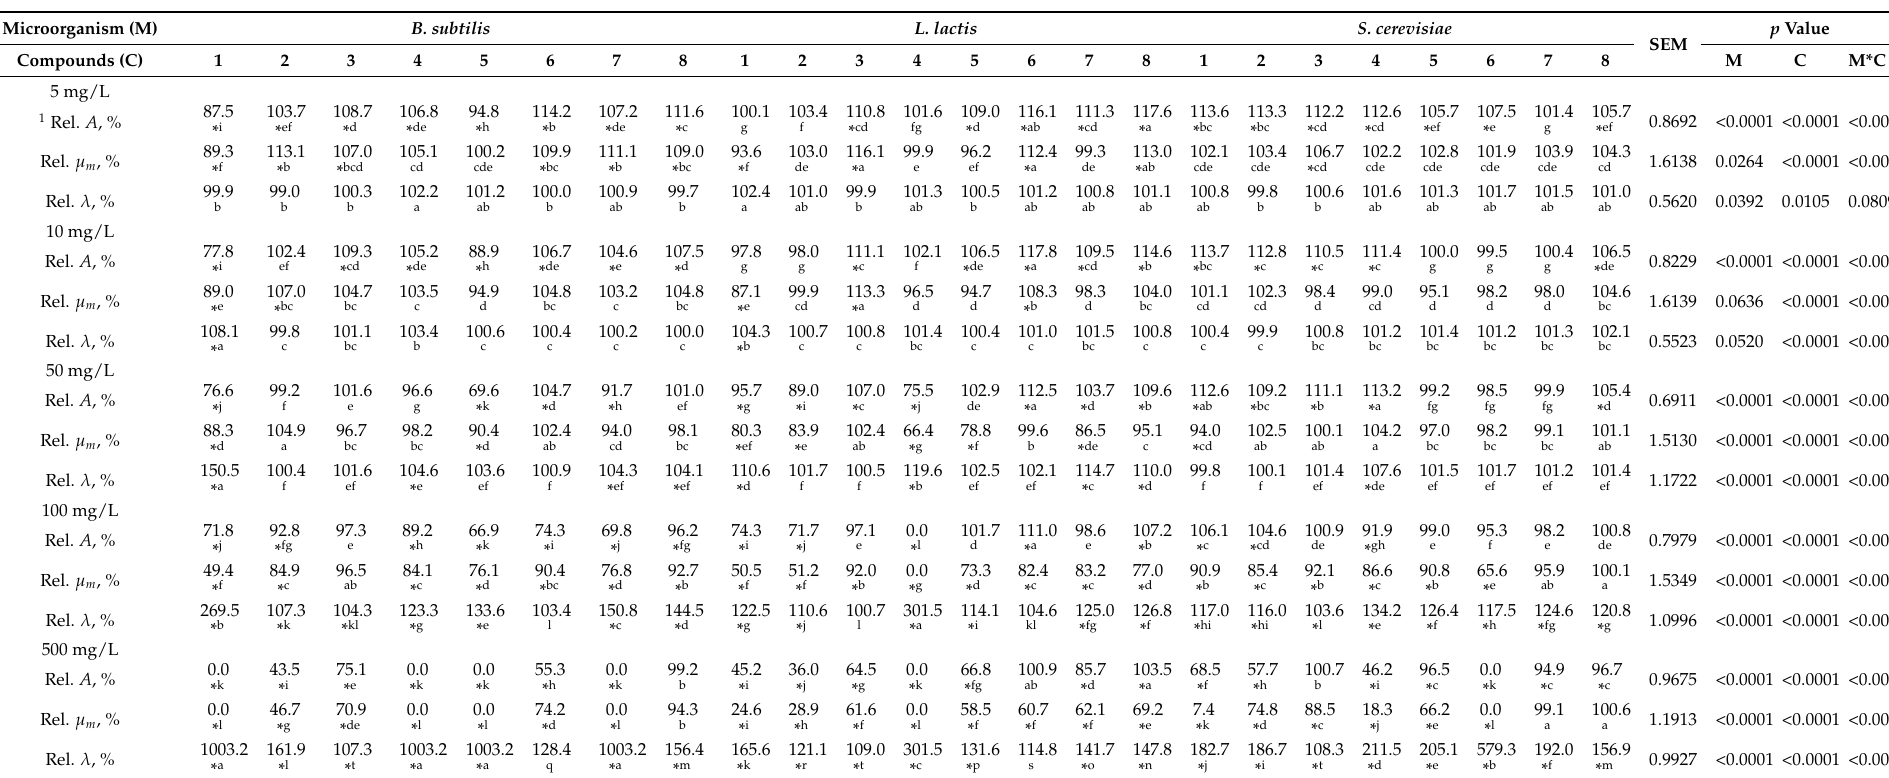
Table 1. Effects of different Zn-compounds and Na 2 EDTA on growth parameters of B. subitis , L. lactis , and S.cerevisiae . Microorganism